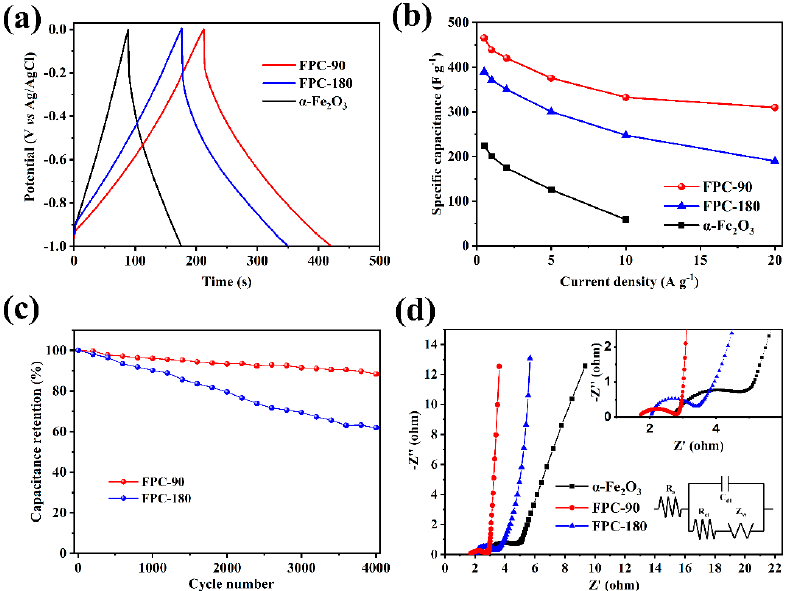
Figure 4. The comparison of GCD curves of different FPC samples ( a ), the rate performance of FPCs electrodes ( b ), and the long − term cycling ability of FPCs electrodes ( c ). Nyquist plot of the different electrodes: the inset is the enlarged image of the high frequency zone ( d ).